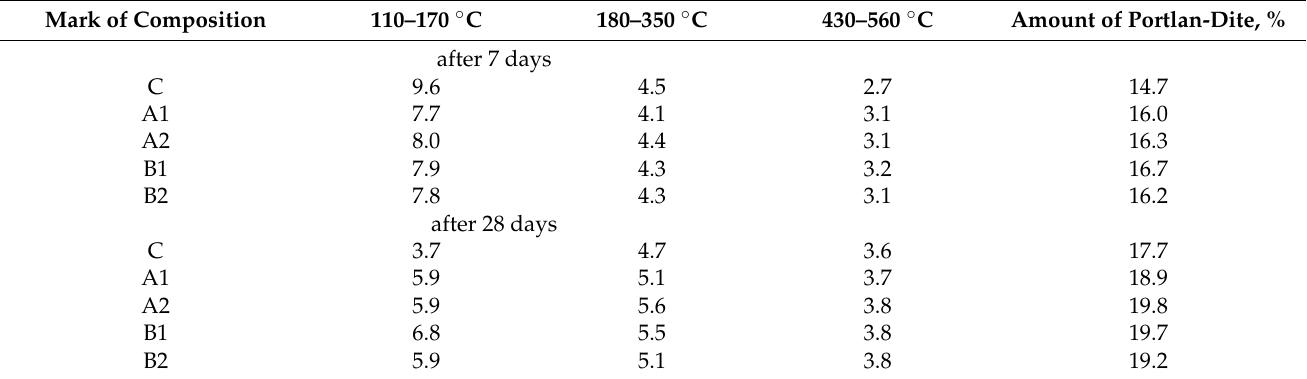
Figure 11. Results of thermal analysis of hardened blended cement paste after 28 days curing . Table 7. Weight loss of hardened cement paste specimens in different temperature intervals (%) .